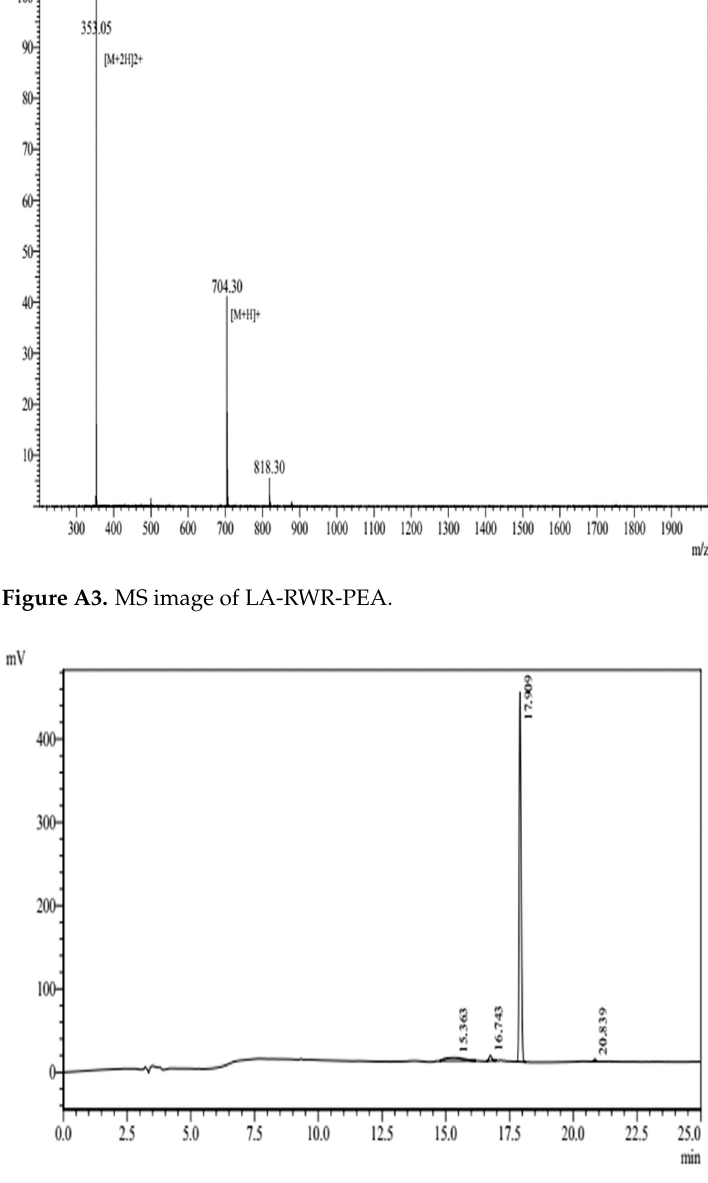
Figure A4. HPLC image of LA ‐ RWR ‐ PEA.